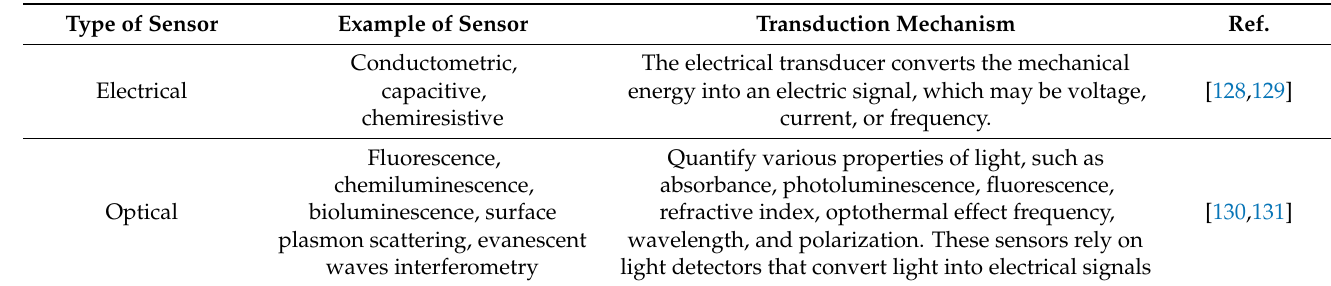
Table 4. Type of chemical sensors with their transduction